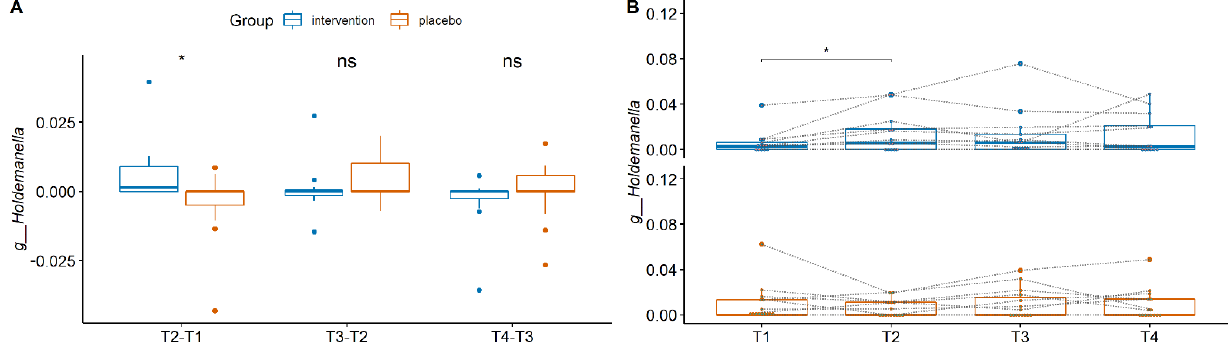
Figure 2. Bacterial taxa that are differentially abundant between the two groups. ( A ) Differences in relative abundances between two consecutive timepoints for the genus Holdemanella . ( B ) The rela ‐ tive abundances of the genus Holdemanella through time within the two groups. ( C ) Differences in relative abundances between two consecutive timepoints for the genus Bifidobacterium . ( D ) The rel ‐ ative abundances of the genus Bifidobacterium through time within the two groups. The boundaries of the box on the bottom indicate the 25th percentile, and the line within the box represents the median, and the boundary of the box on the top the 75th percentile. For panels ( A , C ), the differences between groups were calculated using Mann ‐ Whitney test. For panels ( B , D ), the differences through time were calculated using the paired Wilcoxon Rank test, and data from individual par ‐ ticipants are connected by dotted lines. Stars above bars represent statistical differences compared to the time ‐ matched control samples (* p < 0.05). 4.1. Fecal Short Chain Fatty Acids To characterise the metabolic activity of the fecal microbiota, the concentration of the SCFAs acetate, propionate, butyrate, iso ‐ butyrate and succinate was determined in fecal water of all samples. Results showed that acetate, propionate and butyrate were the main SCFAs detected in the fecal samples but they did not differ significantly between the pla ‐ cebo and the intervention group at any of the timepoints or within the groups between the different treatment phases (Figure 3).